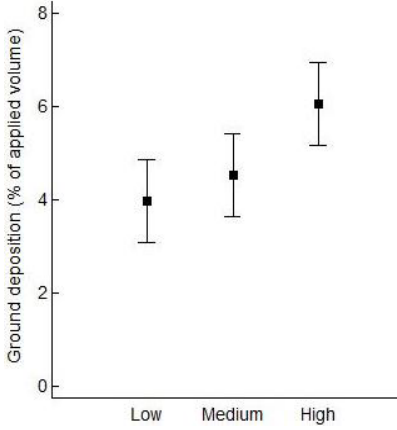
Figure 6. Sedimenting spray drift mean ± SE of the mean.